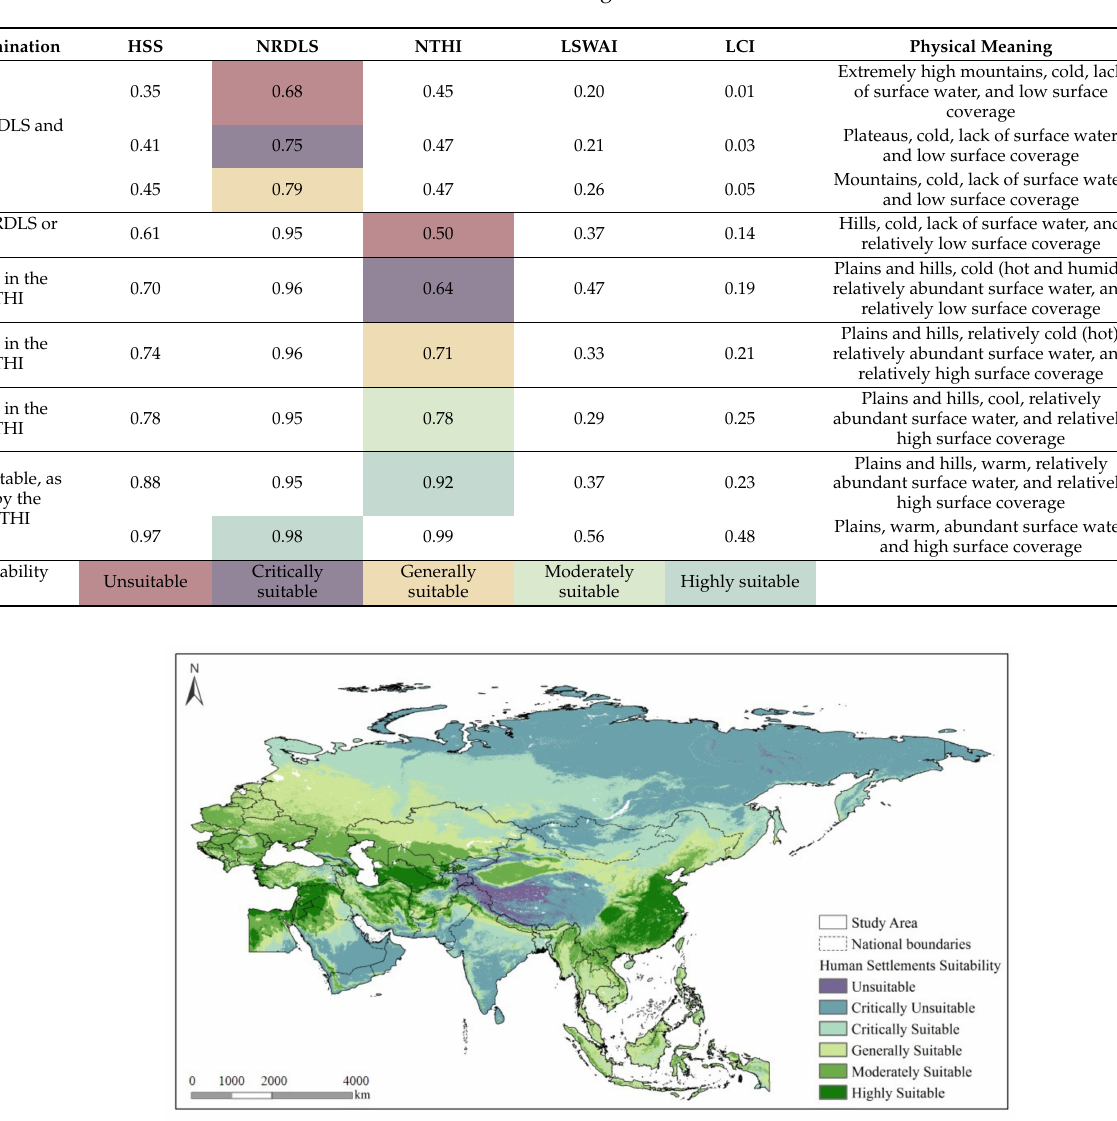
Figure 7. HSS-based